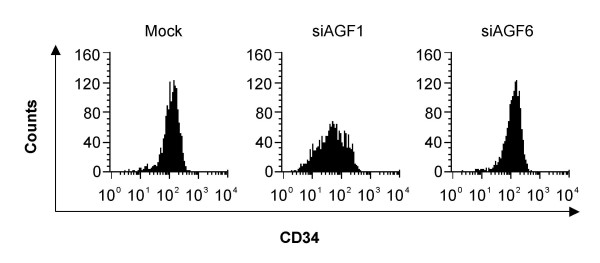
RUNX1-CBFA2T1 depletion diminishes CD34 expression Seven days after electroporation with the indicated siRNAs, cells were analyzed for CD34 surface marker by flow cytometry as described in Material and Methods.